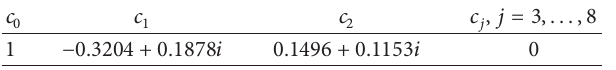
Table 1: Mutual coupling parameters.